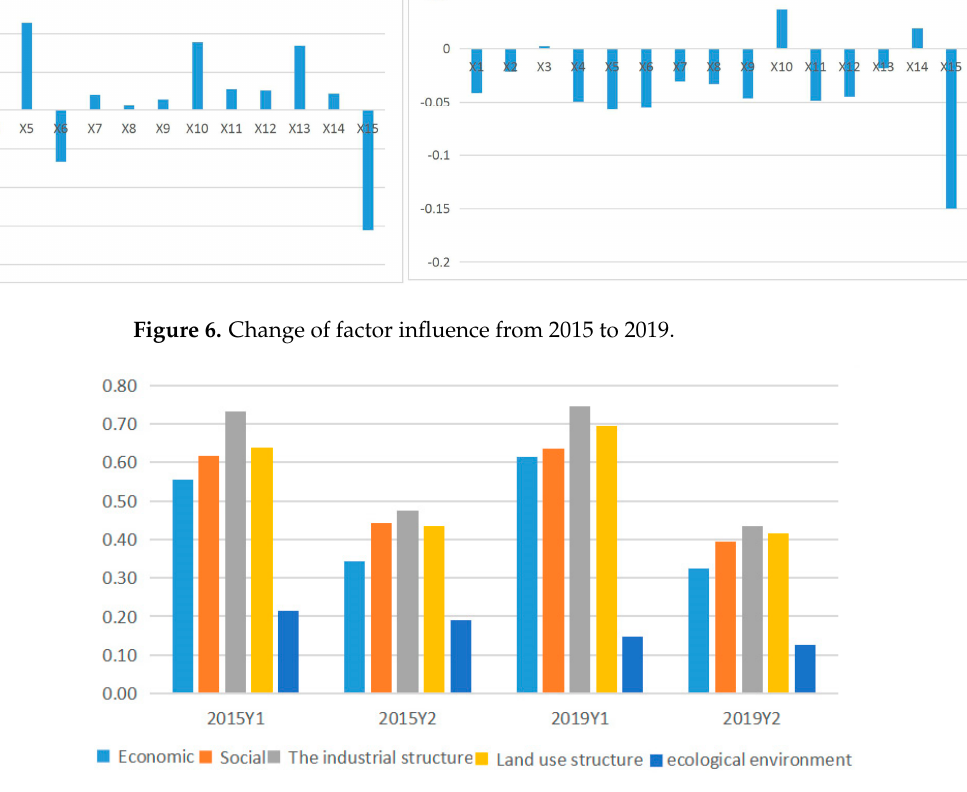
Figure 7. Analysis of driving forces in five aspects.